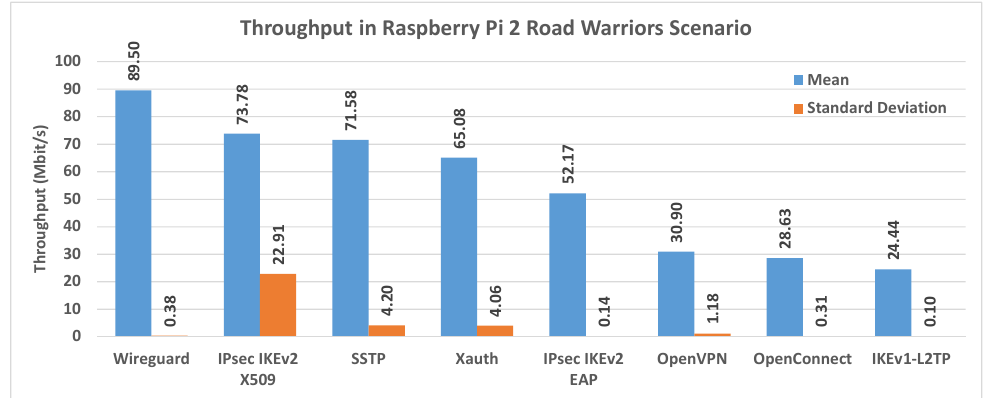
Figure 18. Comparison of Throughputs on Raspberry Pi 2 in all